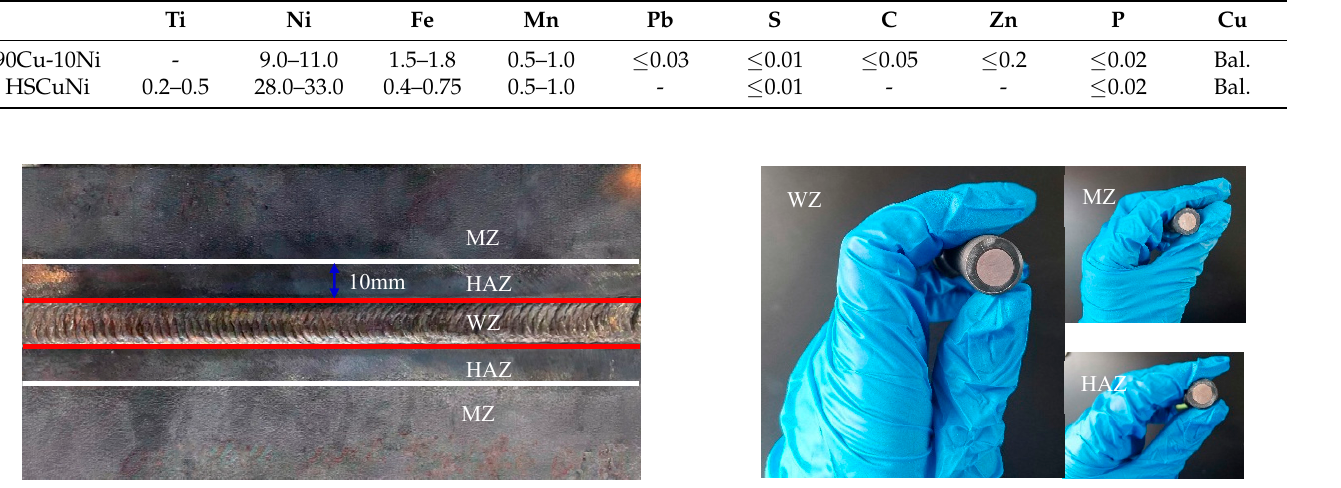
Figure 1. Schematic diagram of cutting position of MZ, HAZ and WZ specimens. Table 1. Chemical compositions of 90Cu-10Ni cupronickel and HSCuNi (wt.%). Ti